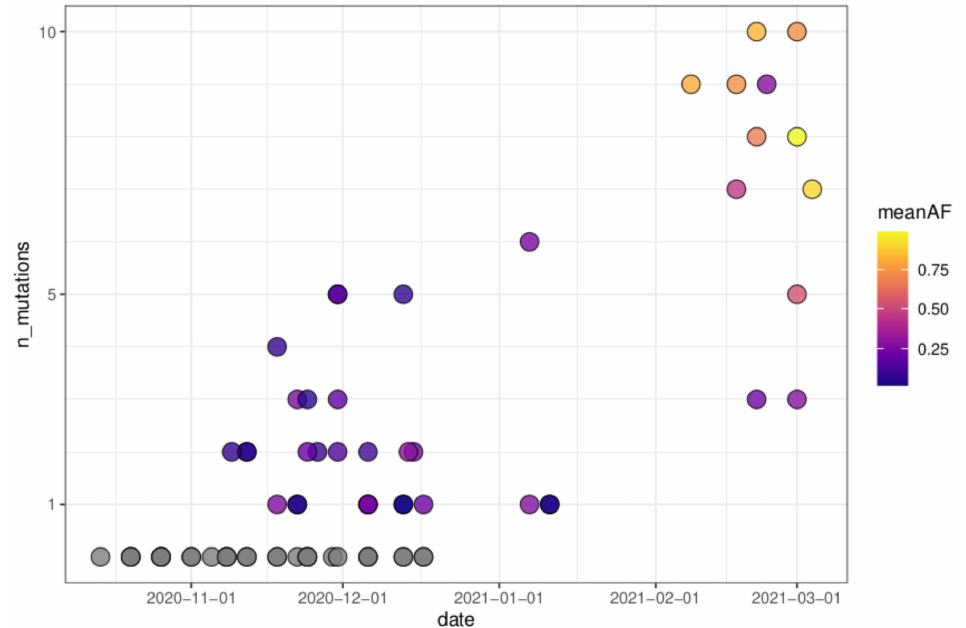
Figure 3. The number of detected unique characteristic mutations (outbreak.info) for B.1.1.7, samples with no detected mutations are shown in grey; otherwise, the coloring represents the mean allele frequency of all signature mutations (11 in total) per sample. Mutations shown here in